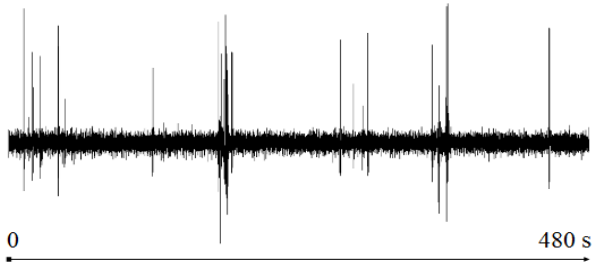
Figure 2. The channel CH 1 ( t ) of the 64-channel EEG.